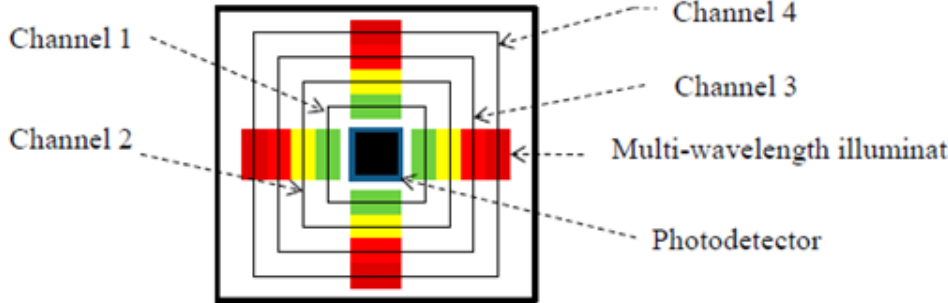
Figure 13. Schematic of opto-electronic patch sensor created by Yan et al. Four channels of NIR LEDs are positioned around a single PD cell. The channel can emit light with varying wavelengths to achieve a higher sensitivity. Image reproduced with permissions from [105].